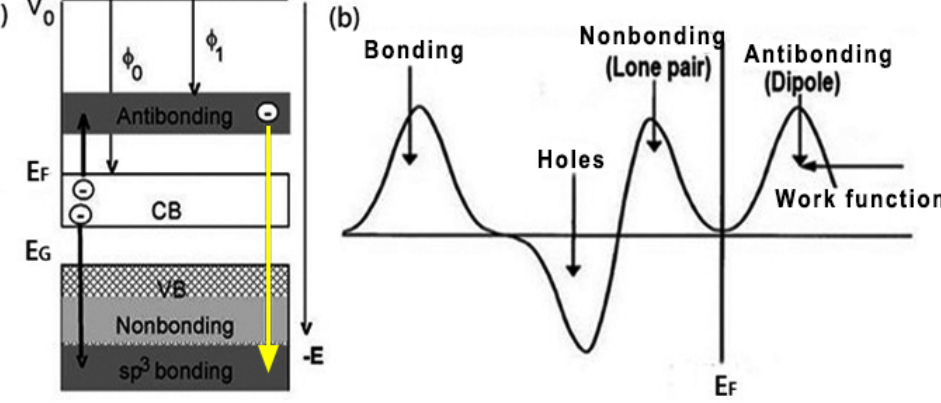
Figure 6. Schematic illustration showing the electronic dynamics associated with fluoridation ( a ) and the four valence DOS features ( b ). The arrows in ( a ) show that F captures electrons from one Z neighbor to form nonbonding lone pairs. These lone pairs induce dipole formation by polarizing the valence electrons of another three neighbors. Further F dosing captures the dipole to continue the bonding processes. The yellow arrow from the antibonding states to the bonding states highlights the process of the formation of H-bond-like interactions [26].